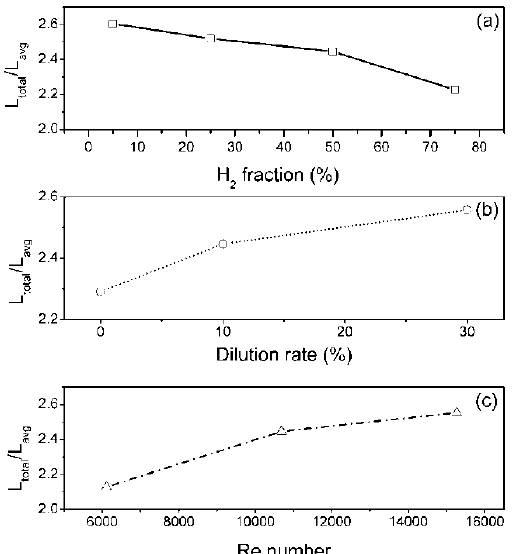
Figure 10. Wrinkled rate under different flame conditions: ( a ) nitrogen dilution volumetric proportion of 10%, Re = 10,690, different hydrogen proportion in fuel; ( b ) hydrogen volumetric rate of 50%, Re = 10,690, different nitrogen dilution; ( c ) nitrogen dilution volumetric proportion of 10%, hydrogen volumetric ratio of 50%, different Reynolds number.